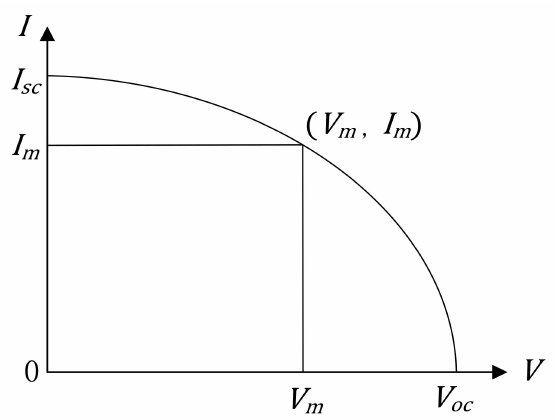
Figure 2. I-V curve of single diode model in solar